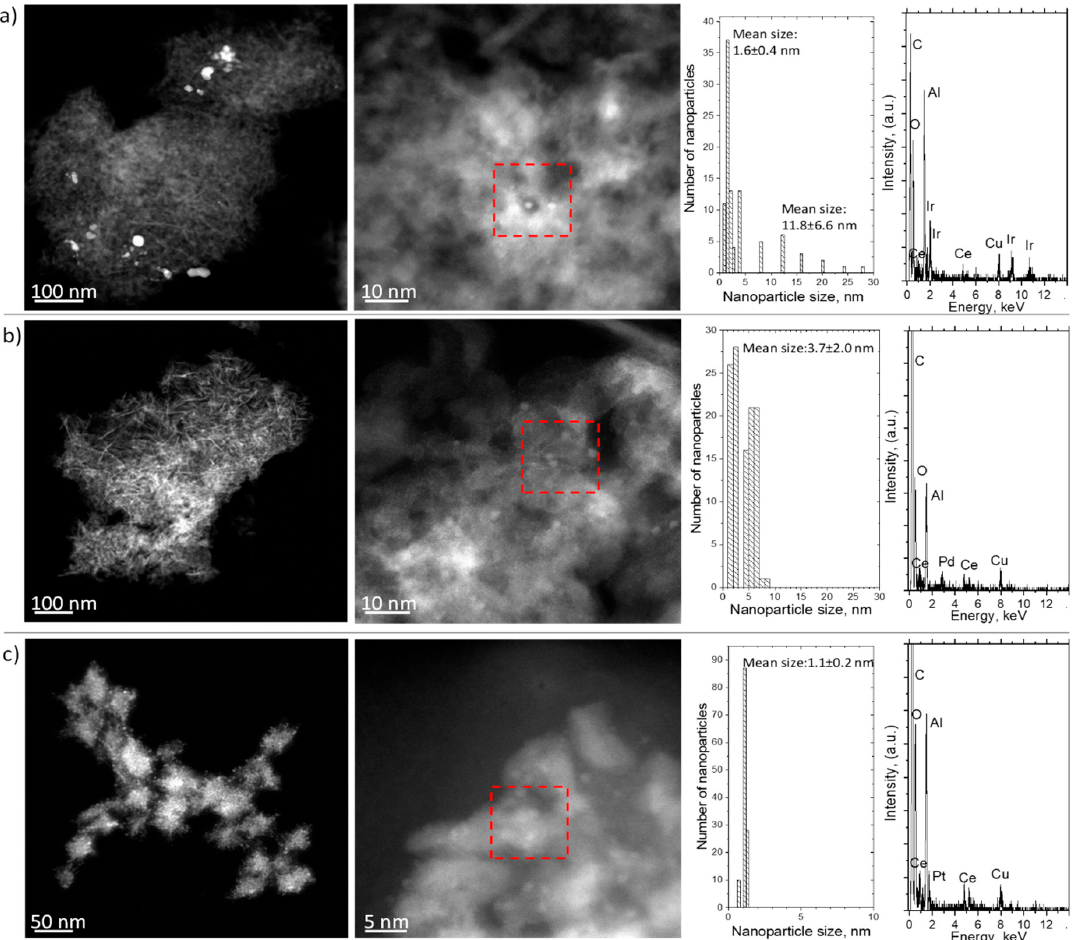
Figure 6. HAADF–STEM images, particle size distribution and EDS spectrum of red-dashed area marked of the reduced: ( a ) Ir / CeAl, ( b ) Pd / CeAl, and ( c ) Pt / CeAl